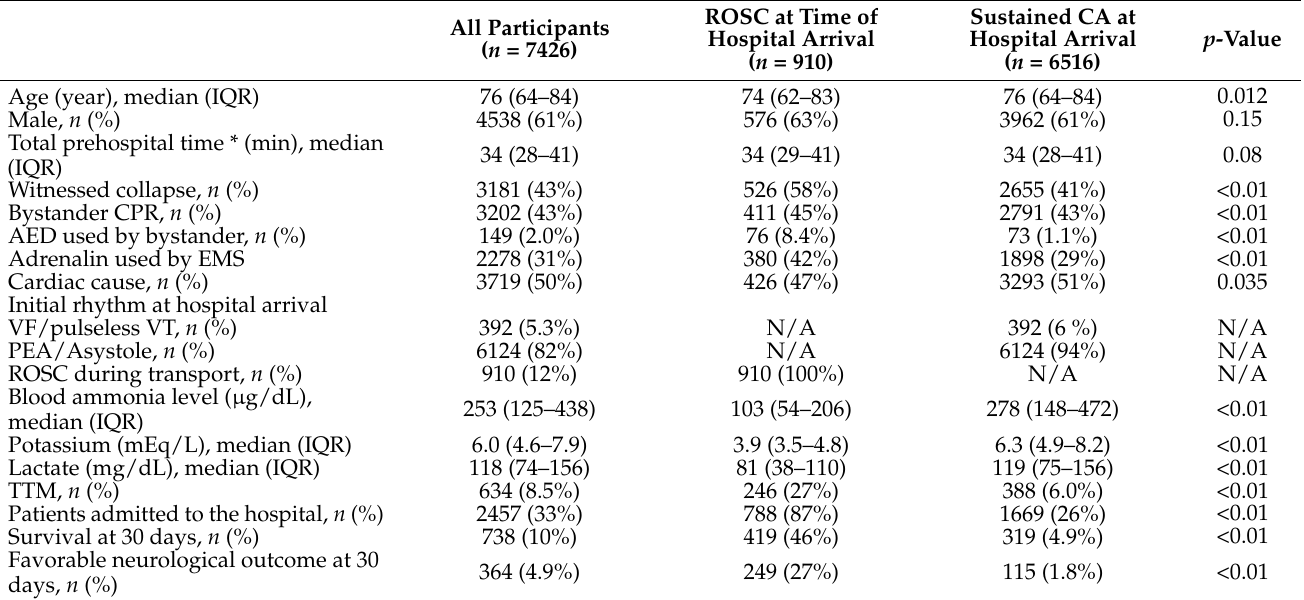
Table 3. Patient characteristics in the ROSC group and the sustained CA group at the time of hospital